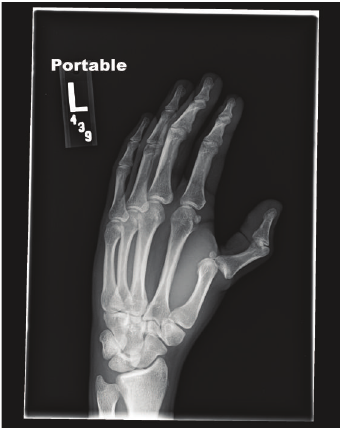
Figure 1: Radiograph demonstrating dislocated metacarpal- phalangeal joint of the first digit.